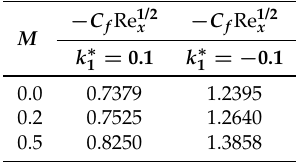
Table 1. Skin-friction coefficient for various estimations of viscoelastic and magnetic